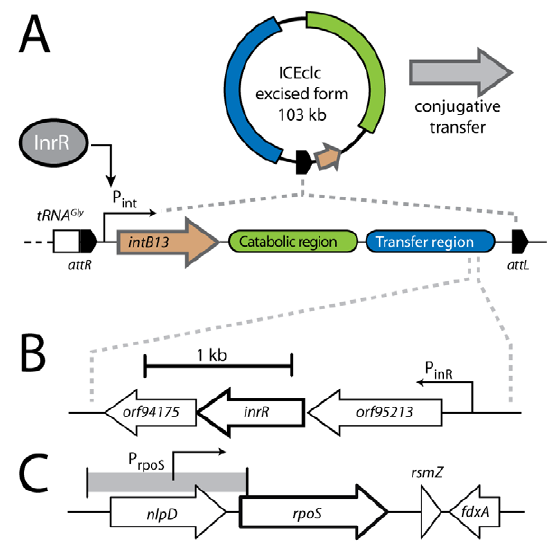
Figure 1. Schematic representation of the ICE clc genetic layout and relevant regulatory features. (A) Excised and integrated ICE clc (not to scale) with its flanking attL and attR sites, and the 18-bp repeat sequences (black pentangle) that are the target of the IntB13 integrase. The ‘transfer region’ denotes the , 50 kb ICE clc part largely conserved with other genomic islands [21]. (B) The region of the open reading frames under control of P inR , among which inrR , the product of which has been implicated in relaying bistable expression to the P int promoter [34]. (C) The gene region around rpoS in strain B13.